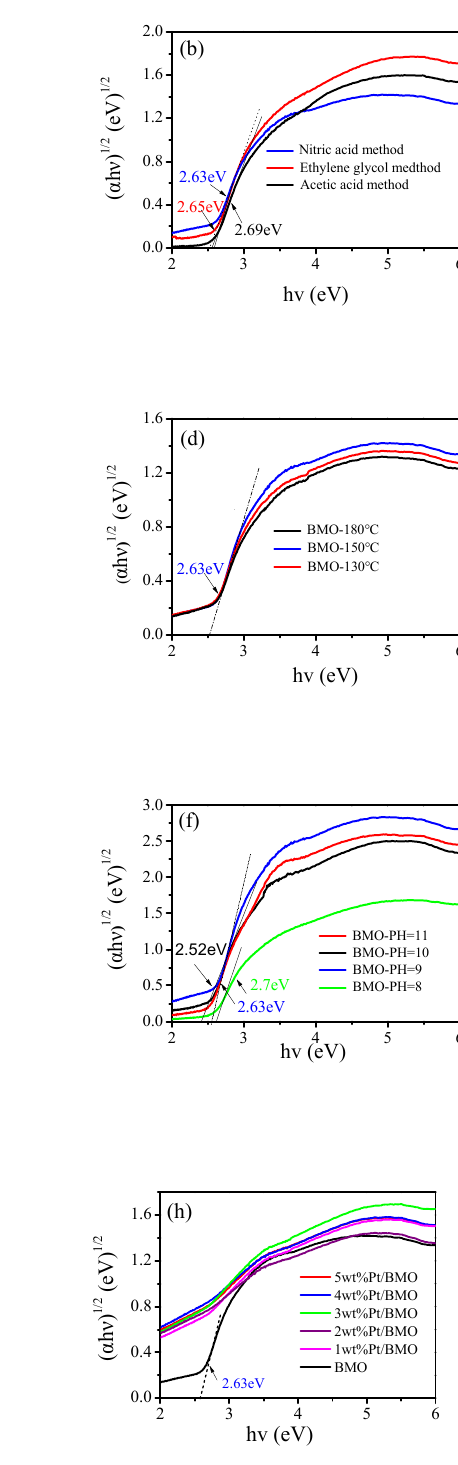
Figure 5. UV-vis di ff use reflectance spectroscopy (DRS) patterns of γ -Bi 2 MoO 6 with: ( a , b ) di ff erent preparation methods, (c,d ) di ff erent hydrothermal temperatures, and ( e , f ) di ff erent pH values and Figure 5. UV-vis diffuse reflectance spectroscopy (DRS) patterns of γ -Bi 2 MoO 6 with: ( a , b ) different UV-vis DRS patterns of Pt / γ -Bi 2 MoO 6 with ( g , h ) di ff erent mass fractions of preparation methods, (c,d ) different hydrothermal temperatures, and ( e , f ) different pH values and UV-vis DRS patterns of Pt/ γ -Bi 2 MoO 6 with ( g , h ) different mass fractions of Pt.